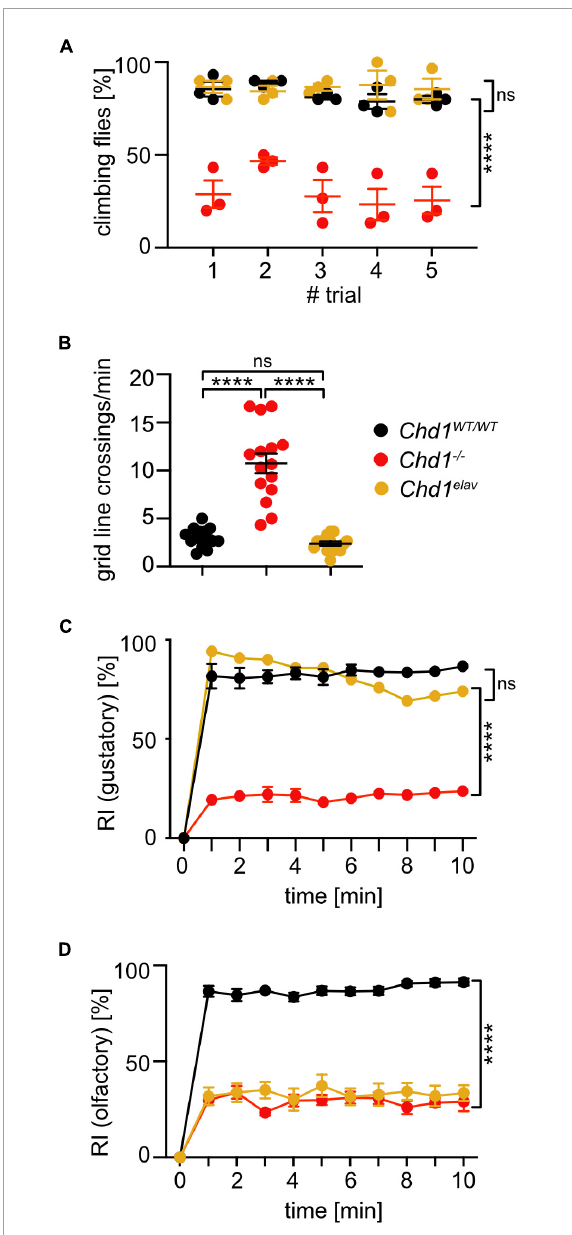
FIGURE4 Pan-neuronal expression of Chd1 rescues locomotory and gustatory impairments but has no effect on olfactory response behavior. (A) Negative geotaxis assay to assess startle-induced climbing behavior. Percentage of 7 days old flies climbing to 8 cm height within 60 s was determined in 5 trials. Mean ± SEM of 3 cohorts of 10 flies each per genotype/experiment from 3 independent experiments is shown. Significant differences between fly lines was determined by unpaired Student’s t -test. **** p < 0.0001, ns, not significant. (B) Gridline crossings in exploratory walking assay of individual 7 days old flies during 1 min were scored. Three independent experiments of n > 15 per genotype/experiment were performed. Statistical significance was determined by unpaired Student’s t -test. **** p < 0.0001. (C) Attraction response index (RI) to sucrose of 7 days old flies was tested as described in Figure 2 . Mean ± SEM